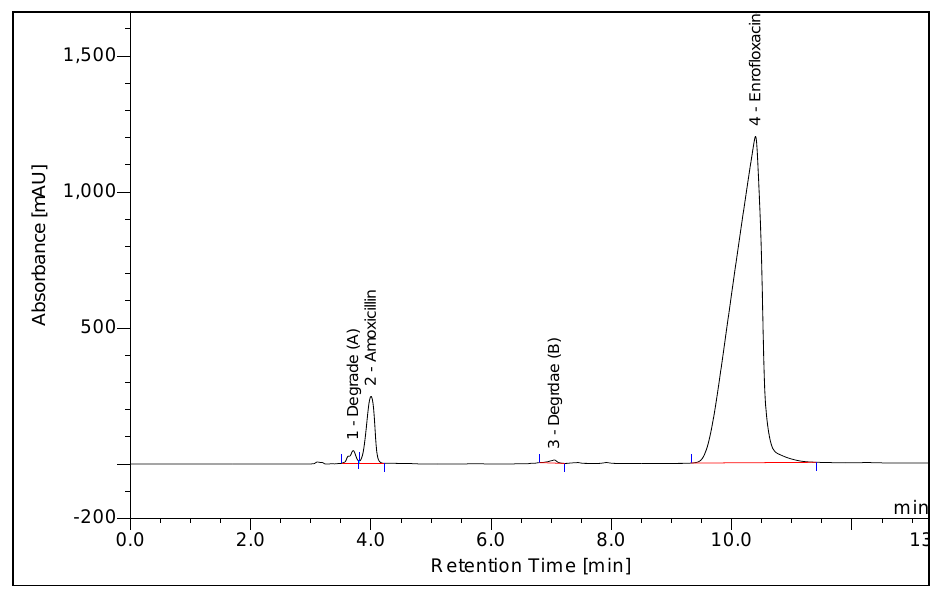
Figure 2. Chromatogram of well-separated peaks of the active ingredients (amoxicillin and enrofloxacin) and the degradative materials. Concentration of amoxicillin and enrofloxacin is 0.8 and 0.4 mg/mL, respectively. Degrade A and B are degradants from Amoxicillin.